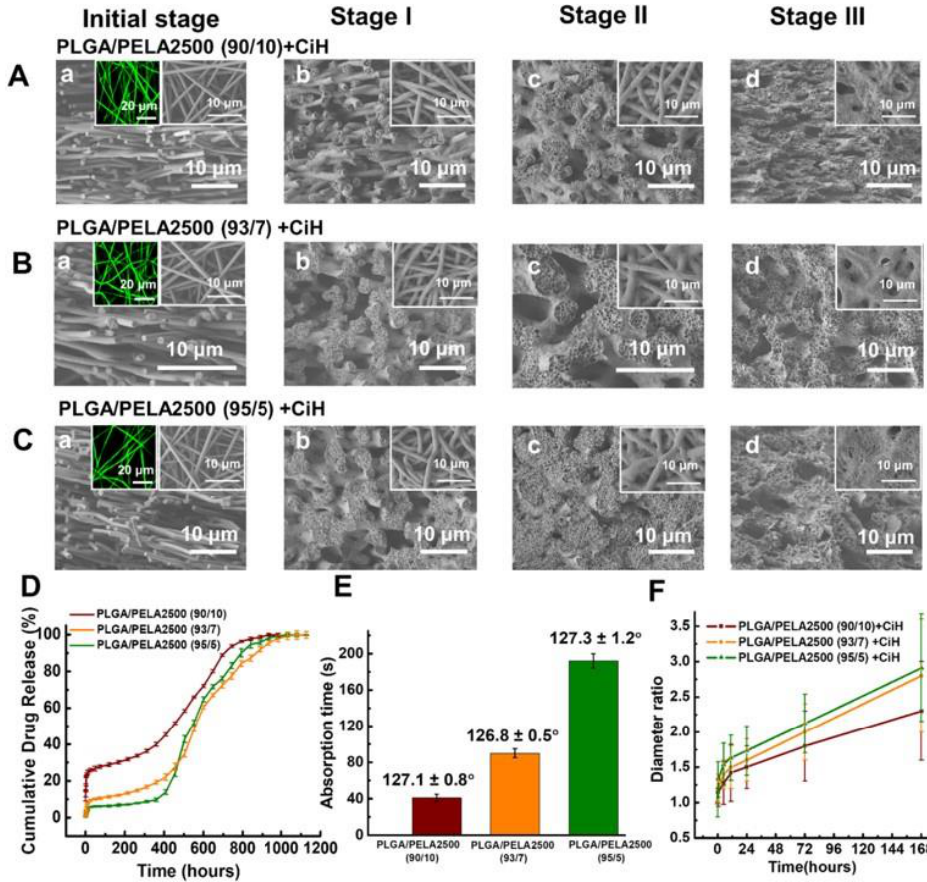
Figure 3. Characterization of PLGA/PELA2500/CiH electrospun membranes with different contents of the second component PELA2500. ( A – C ) Cross-sections of PLGA/PELA2500/CiH membranes: ( A ) PLGA/PELA2500 (90/10); ( B ) PLGA/PELA2500 (93/7); ( C ) PLGA/PELA2500 (95/5). ( D ) In vitro drug release profiles of PLGA/PELA2500/CiH membranes. ( E ) Changes in the absorption time of PLGA/PELA2500/CiH membranes the values of the contact angles of the membranes. ( F ) Changes in the fiber diameter ratio of PLGA/PELA2500/CiH membranes. © 2020 The Authors. Published by Elsevier B.V, under CC-BY-NC-ND license.